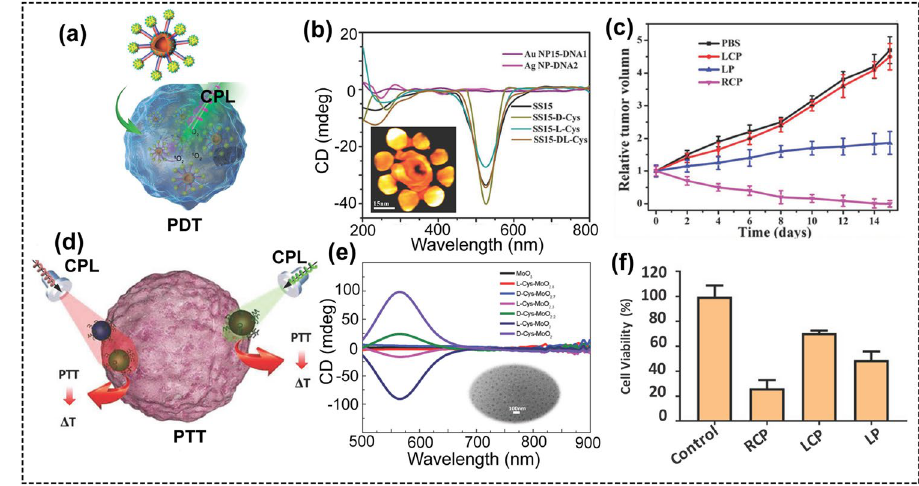
Fig. 9 a Illustration of self-assembled shell–satellite (SS) nanostructure as a chiral photodynamic therapy agent under CPL illustration. b CD spectra of the chiral SS15 nanostructure. The inset is the 3D tomography of the SS15 nanoassembly. c The relative tumor growth curves after various treatments: PBS only, SS15 assembly + LCP light, SS15 assembly + LP light, and SS15 assembly + RCP light (reproduced with permis- sion from Ref. [96]. Copyright 2017, WILEY–VCH GmbH). d Scheme for the synthesis of Cys-MoO3−x NPs and their applications for tumor cell ablation via CPL radiation. e CD spectra of chiral Cys-MoO3−x NPs. f Viability of HeLa cell incubating with chiral D-Cys-MoO2 (50 µg mL−1) after 532 nm RCP, LP, and LCP irradiation (1 W cm.−2 for 15 min) was analyzed by CCK-8 assay (reproduced with permission